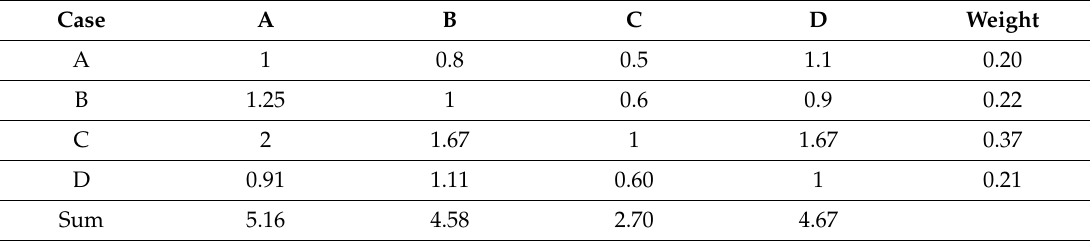
Table A6. Pairwise comparison of alternatives based on